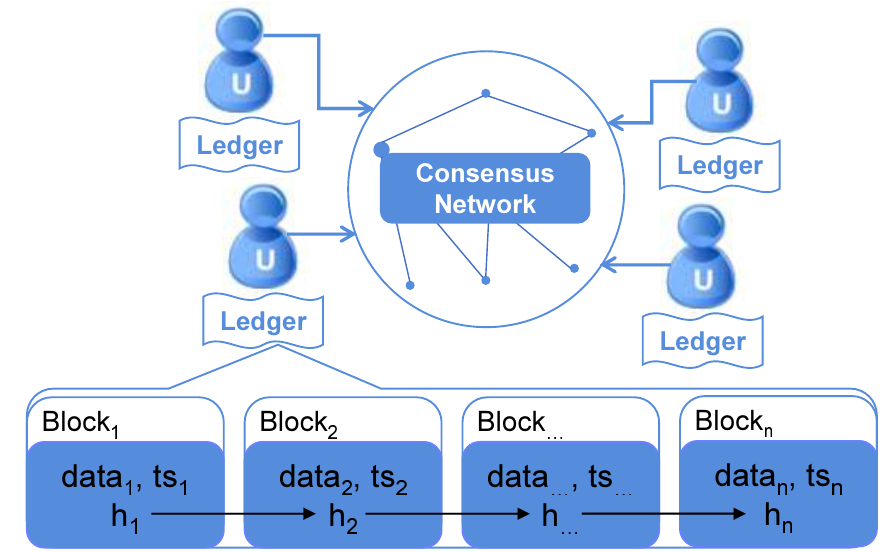
Figure 1. The structure of the permissioned blockchain